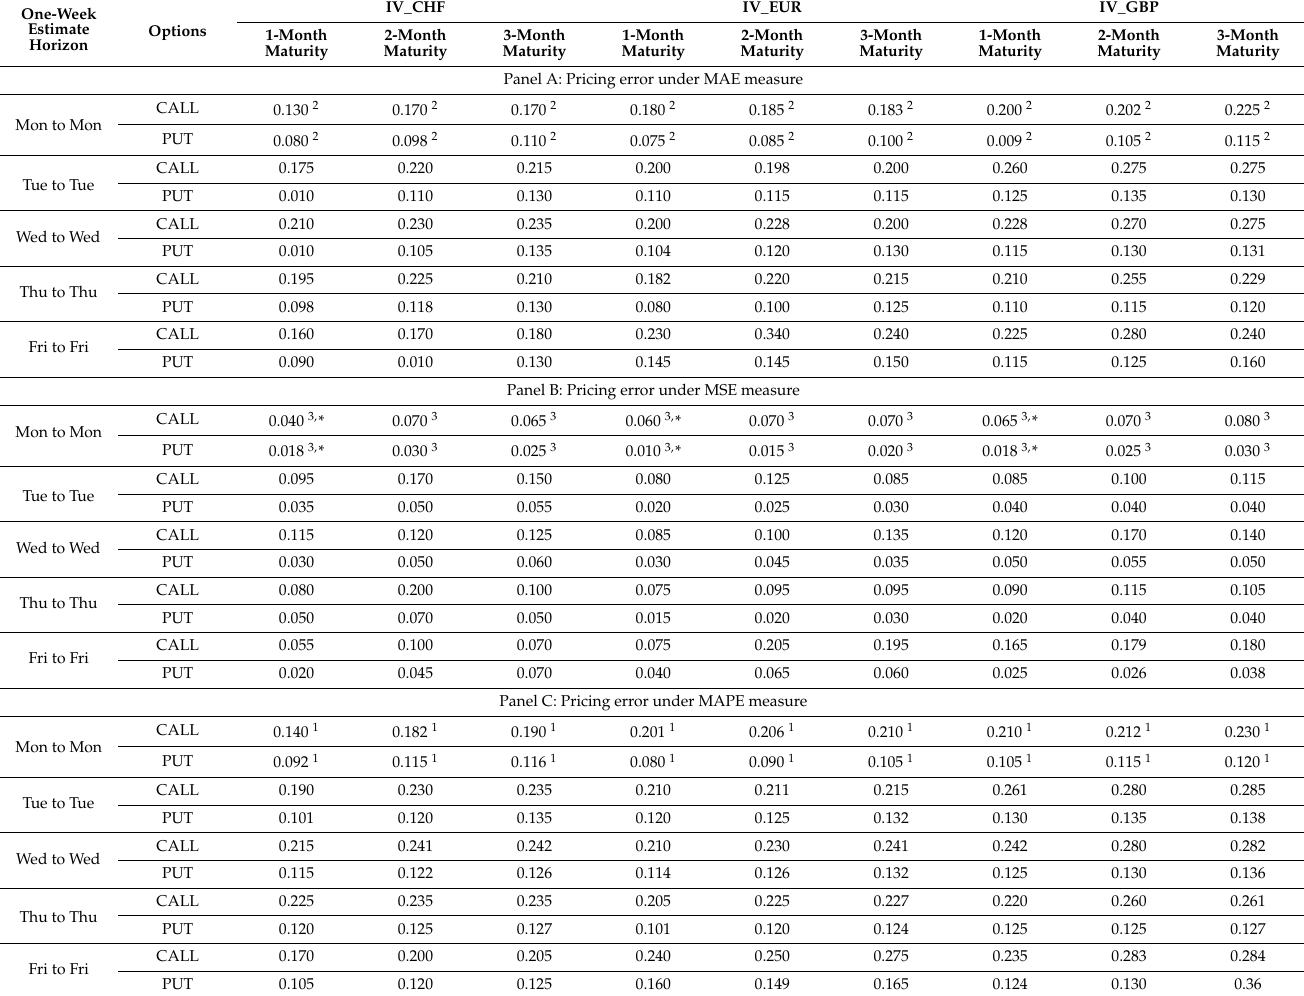
Table 5. Estimate options pricing error for the one-week horizon.